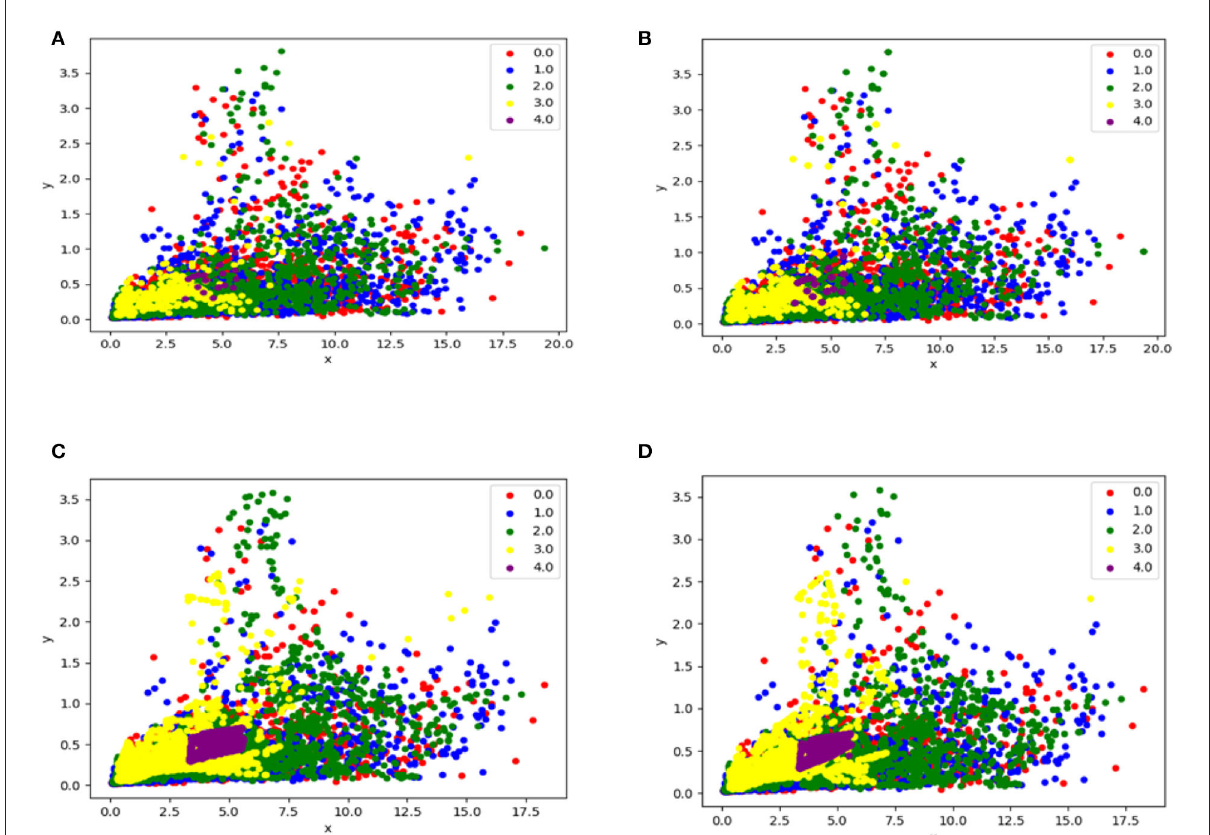
FIGURE3 This figure illustrates the difference between before and after cases using over-sampling techniques, (A) is data without any resampling method, (B) is data after applying Random-oversampling resampling method, (C) is data after applying SMOTE resampling, (D) is data after applying Borderline SMOTE